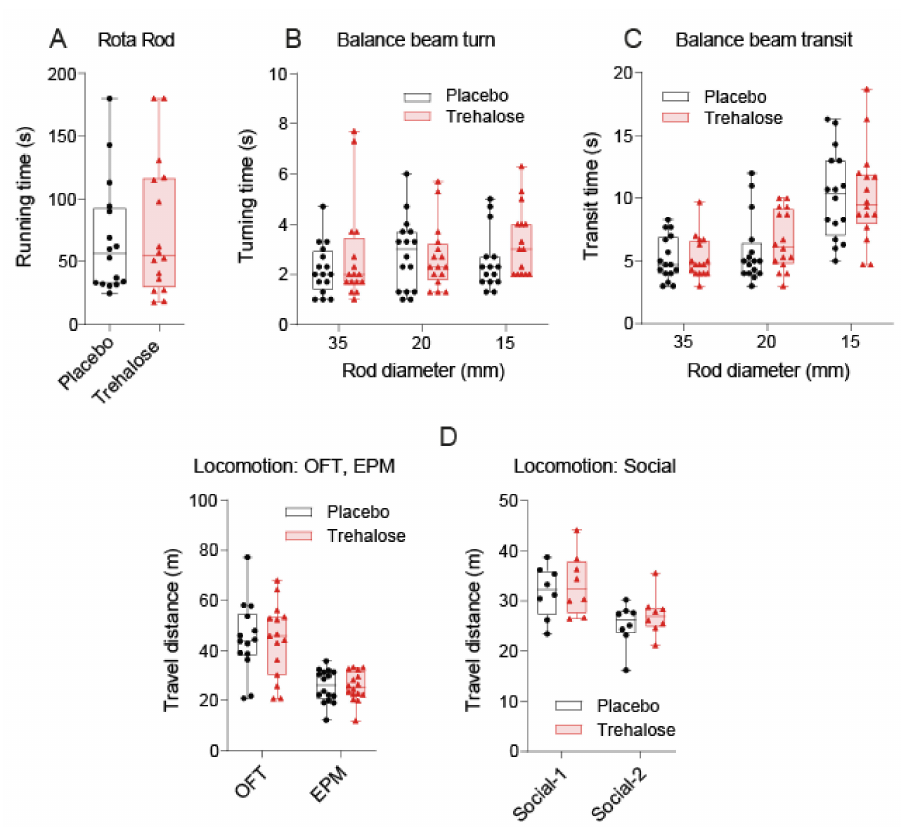
Figure 2. Motor behavior in trehalose. and placebo-treated mice 5–6 weeks after SNI. ( A ): Running time on a constant speed Rotarod. The fall-off latency did not differ between groups. ( B,C ): Turn around and transit time on a static balance beam with decreasing diameters (35, 20, 15 mm). ( D ): Travel distances in the Open Field Test (OFT), Elevated Plus Maze (EPM) tests, and 3-Chamber test of sociability and social memory. The box shows the interquartile range, the line the median, the whiskers minimum to maximum, the scatters individual mice ( n = 16 per group, n = 8 per group for the social test). Data were compared with unpaired, 2-tailed Student’s t -tests or 2-way ANOVA for balance beam tests, using “diameter” X “treatment” as within- and between-subject factors. There were no differences between the treatment